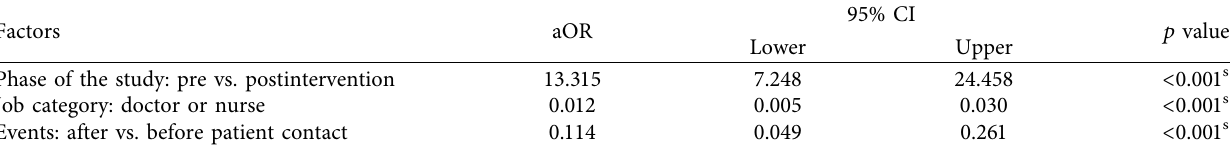
Table 7: Binary logistic regression analysis of potential factors determining hand hygiene noncompliance in the NICU.